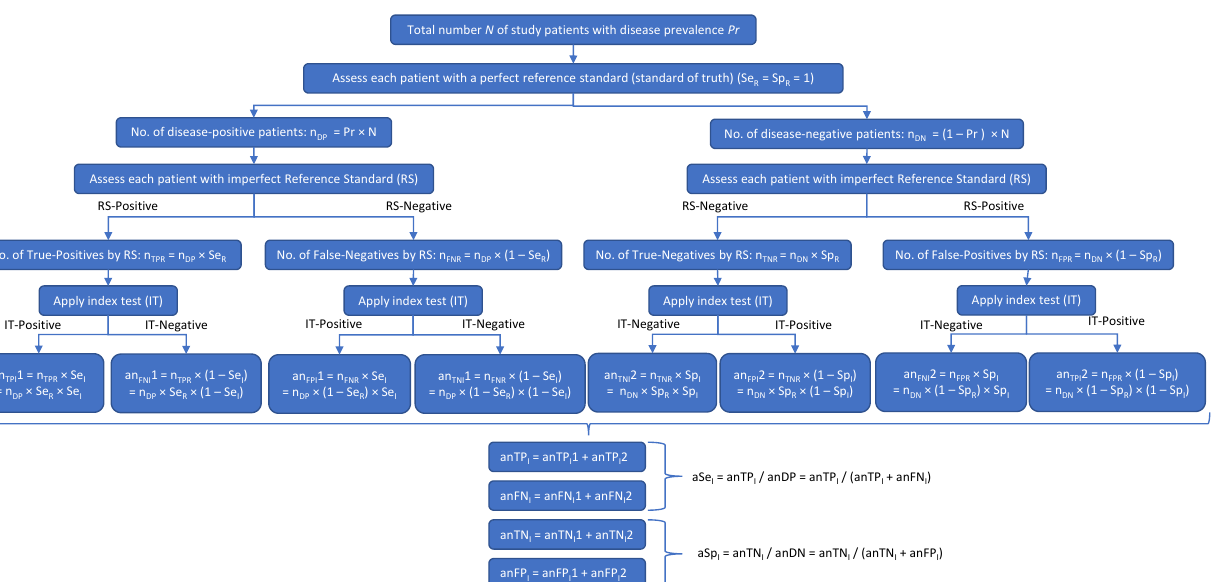
Figure 1. When an imperfect RS is used in a clinical study of an investigational test, the apparent number of disease-positive subjects may include some subjects who are actually disease negative, as well as subjects who are truly disease positive. Likewise, the apparent number of disease-negative subjects may include some subjects who are actually disease positive, as well as subjects who are truly disease negative.